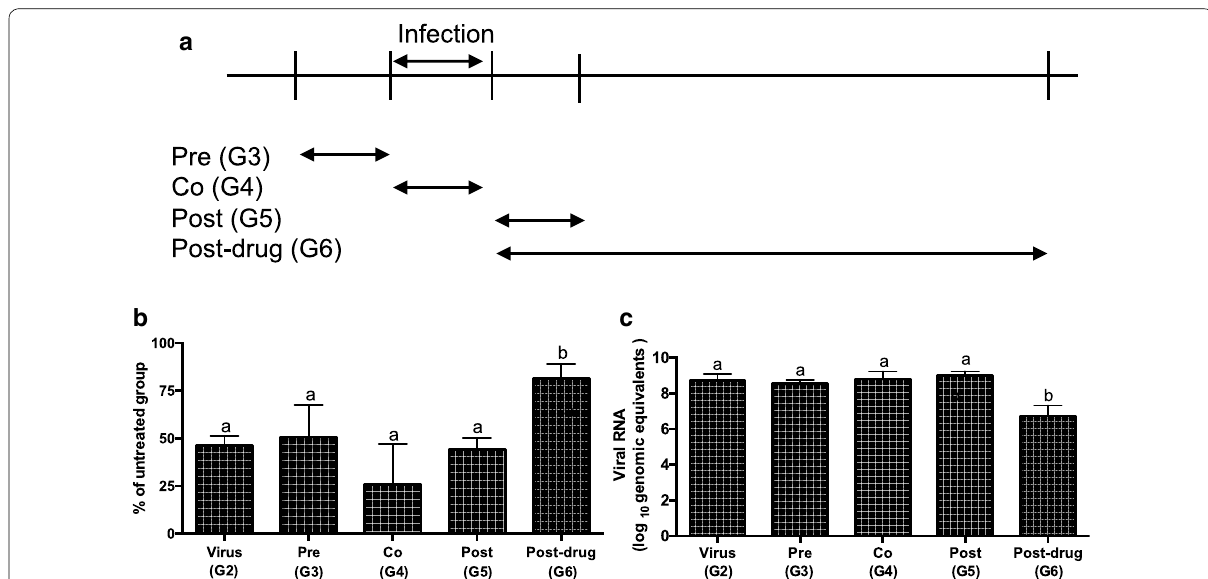
Fig. 7 Time‑of‑addition assay of the BLFP crude extract. a Plot of the time‑of‑addition assays for BLFP crude extract treatment. 150 ppm of BLFP crude extract was added to PEDV‑infected cells with various treatments. b Evaluation of antiviral activity of BLFP crude extract by AlamarBlue ™ assay. c Detection of viral RNA of PEDV in the supernatants. Statistical analysis was performed by one‑way ANOVA and followed by Tukey’s multiple comparisons test. a , b significant differences between groups are indicated with different letters ( p <